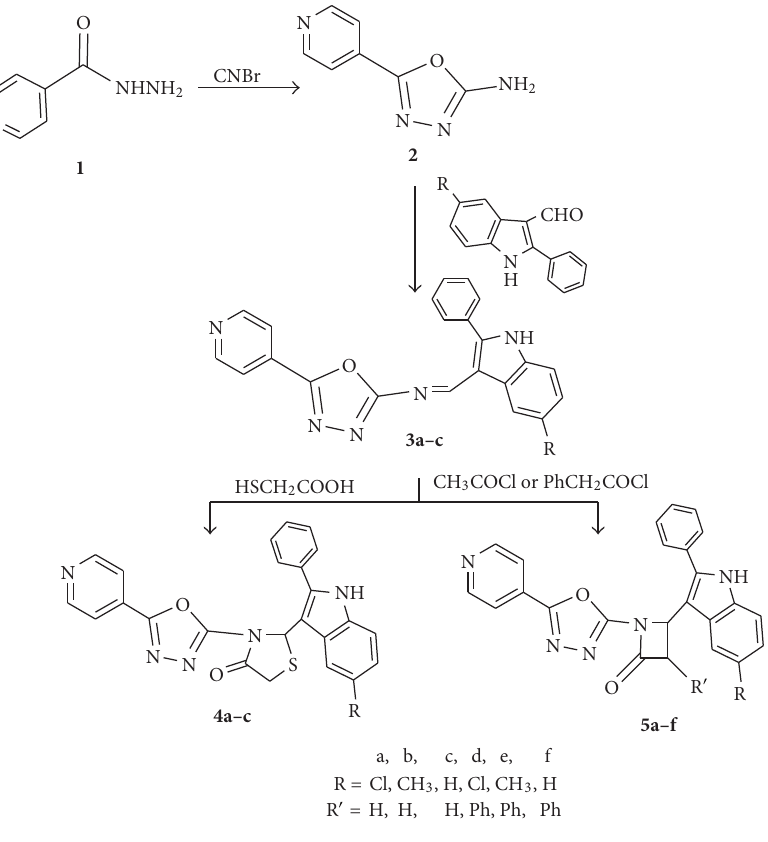
S 1: Synthesis of indole analogues ( 3–5